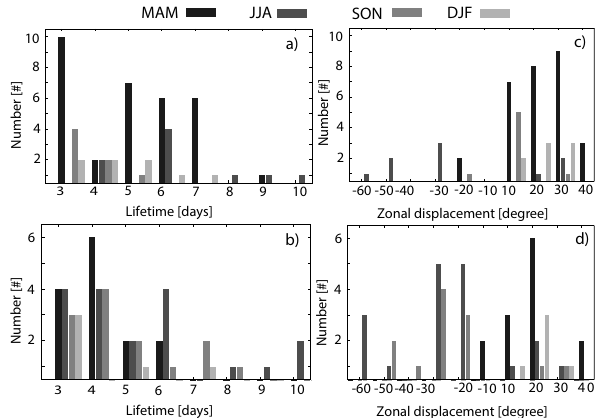
Figure 6. Histograms of characteristics from long-lived and migrat- ing cyclones. Cyclone life times for 1989–2008 forming (a) in the north (15 ◦ W–35 ◦ E, 20–32 ◦ N), and (b) in the south (15 ◦ W–35 ◦ E, 0–20 ◦ N); and zonal displacement of cyclone centres during their life time forming (c) in the north, and (d) in the